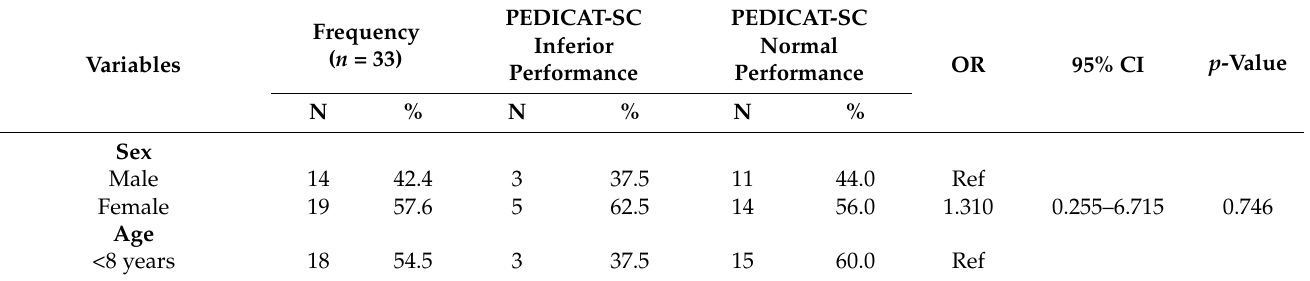
Table 3. Frequency, number of children with inferior and normal performance in PEDICAT-Social Cognitive, odds ratio, 95% confidence interval, and p